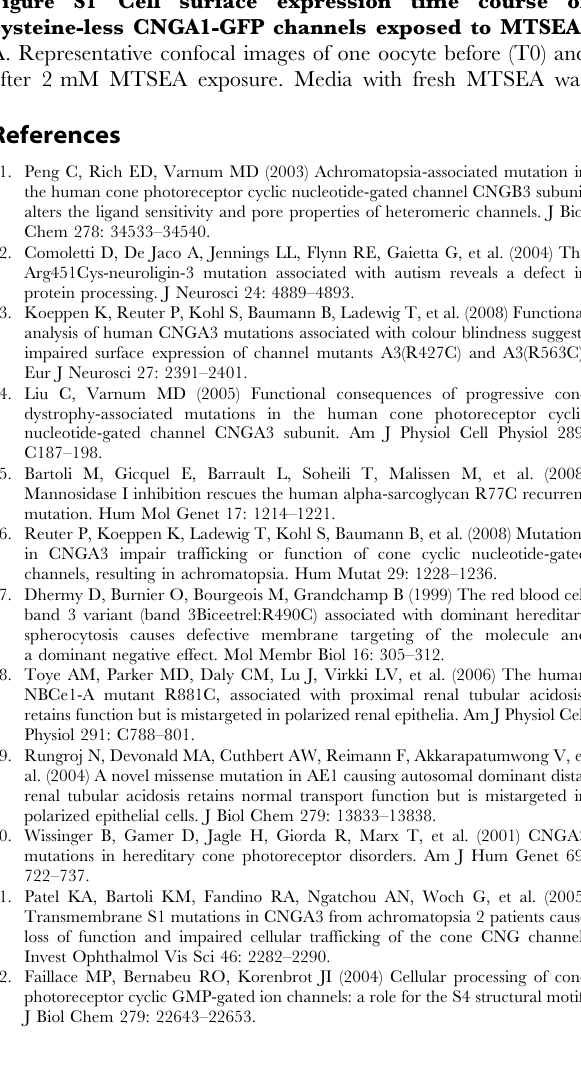
surface expression of ‘‘wild-type’’ channels. (TIF) Figure S2 Cell surface targeting of S4 cysteine mutants by chemical modification. All images shown were obtained after immunocytochemical labeling of oocytes expressing CNGA1 arginine to cysteine mutations in the S4 transmembrane segment. The absence of fluorescence at the oocytes’ cell membrane (left column) indicate that these arginine to cysteine mutations in the S4 segment render immature channels that are unable to reach the cell surface. After 6 h MTSEA treatment, we were able to restore proper trafficking to these mutant channels (right column). Representative of . 10 cells in each panel.